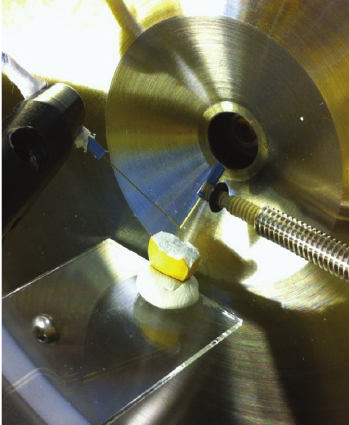
Figure 1: Photograph of the nano-DESI MS setup for online sampling and analysis from the surface of a fractured